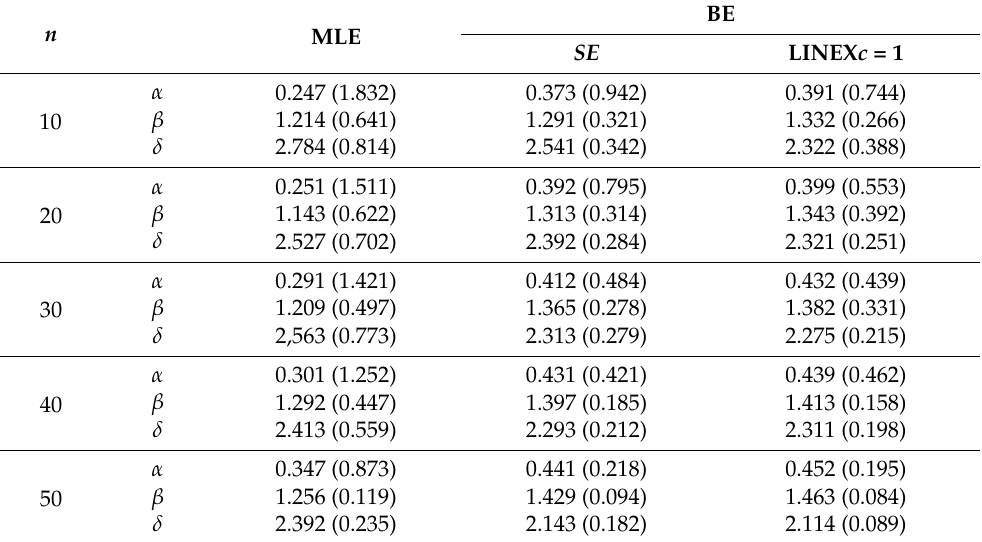
Table 3. Lengths and coverage probabilities (CPs) of 95% CIs of the parameters ( α = 0.5, β = 1.5, δ = 2 ) and values of the prior a a 3 = 0.35, b 3 = 0.25.